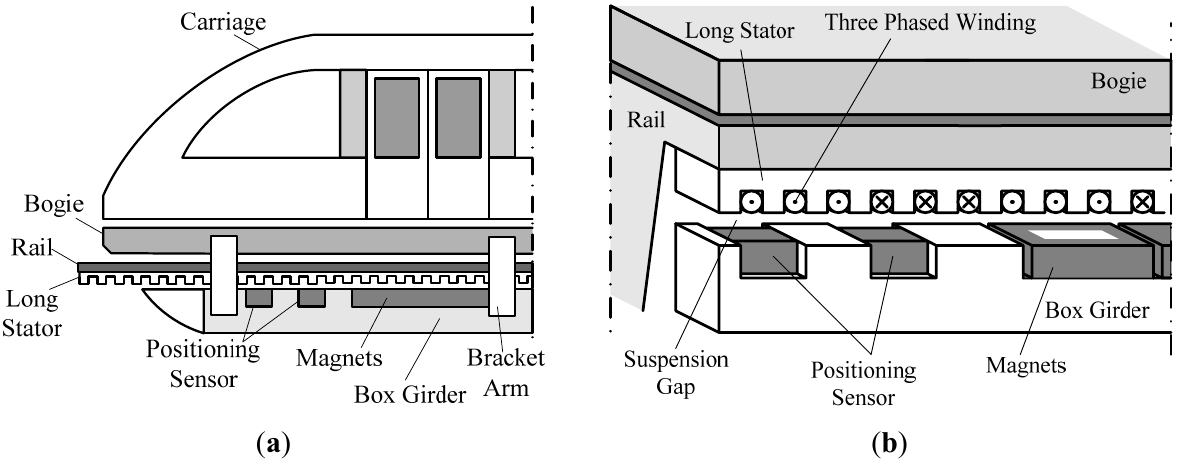
Figure 1. ( a ) Sketch map of a high speed maglev train; ( b ) Sketch map of the substructure of a high speed maglev